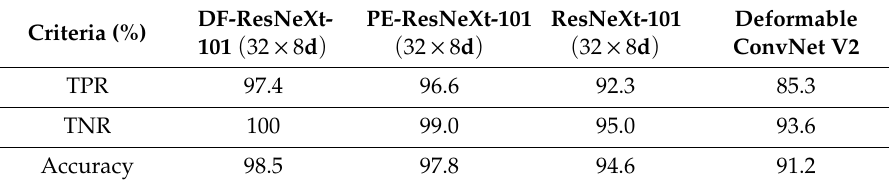
Table 7. Experimental results for the case